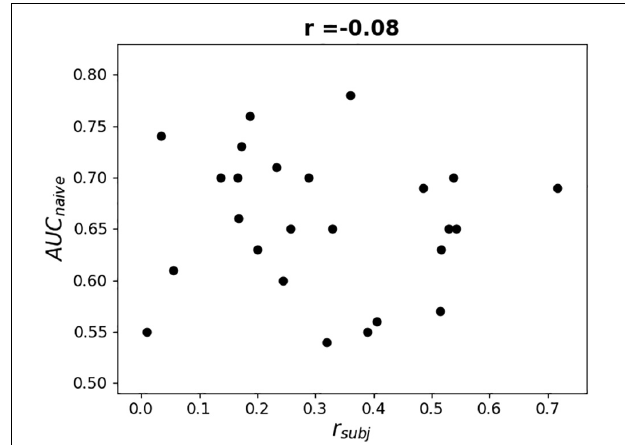
FIGURE 10 | Dependence of AUC obtained by naïve testing procedure on Pearson correlation coefficient value between L1-norm of frontal sensors weights in each LS and L1-norm of LS’s output weights (see Figure 9